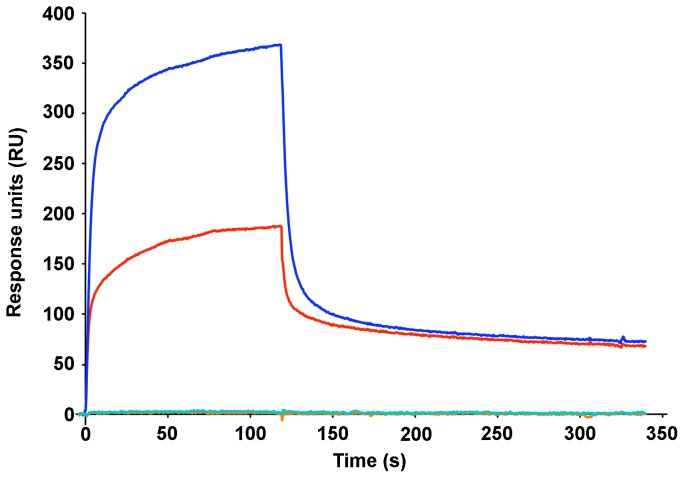
Direct binding to blood group trisaccharides assayed by surface plasmon resonance.Representative real-time association and dissociation profiles corresponding to the injection of the Head(wt) region (175 nM) over trisaccharide A (blue) or trisaccharide B (red) conjugated BSA. Premixing the Head(wt) region with a 2-fold excess of heparin resulted in no detectable binding to either conjugate (cyan and orange profiles for trisaccharide A- and trisaccharide B-BSA, respectively).